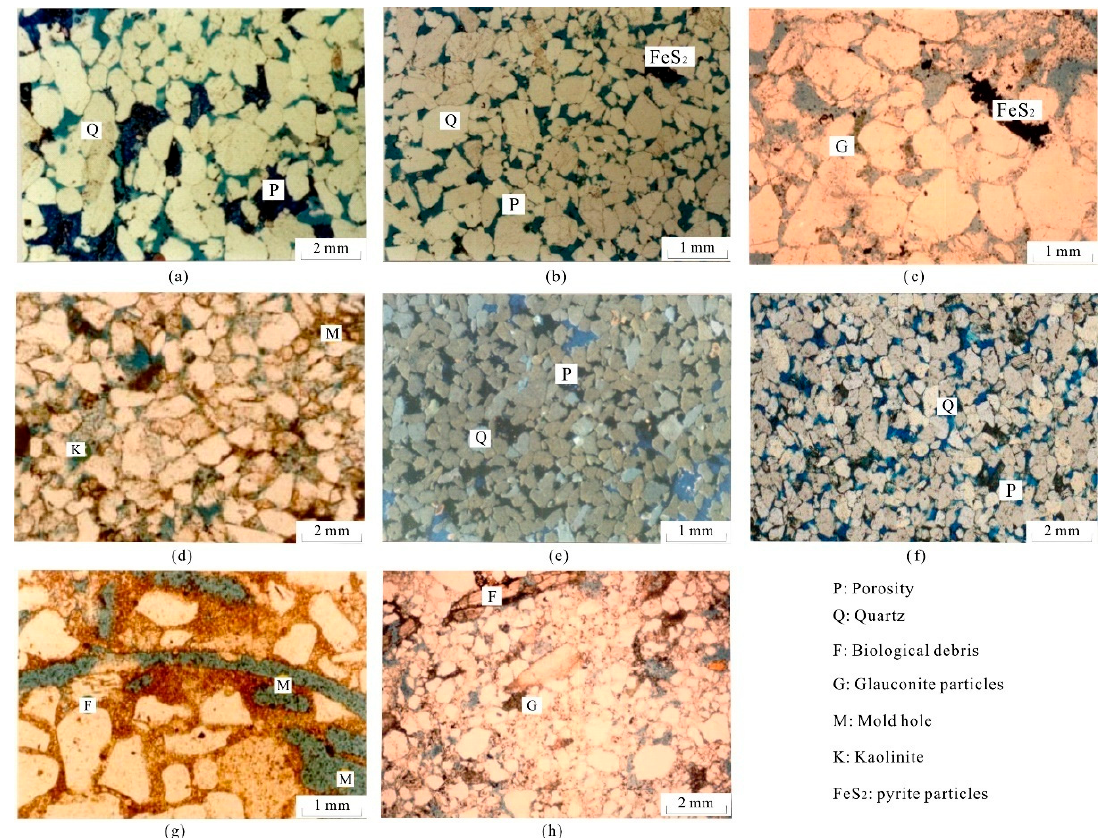
Figure 3. Casting thin-section images of sandstone samples from the southern Indus basin. ( a ) medium-fine grained sandstone, high quartz content, well sorted, subround, particle point-line contact, development of primary pores; ( b ) fine grained sandstone, high quartz content, moderately sorted, development of primary pores and pyrite particles; ( c ) fine grained sandstone, high quartz content, development of primary pores, pyrite particles and glauconite; ( d ) argillaceous fine sandstone, moderately sorted, subangular, development of kaolinite and mold holes; ( e ) siltstone, moderately sorted, well sorted, development of primary pores; ( f ) fine grained sandstone, high quartz content, moderately sorted, subangular, development of primary pores; ( g ) fine grained sandstone, moderately sorted, subangular, development of few biological debris and mold holes; ( h ) argillaceous siltstone, poorly sorted, subangular, development of glauconite and biological debris.